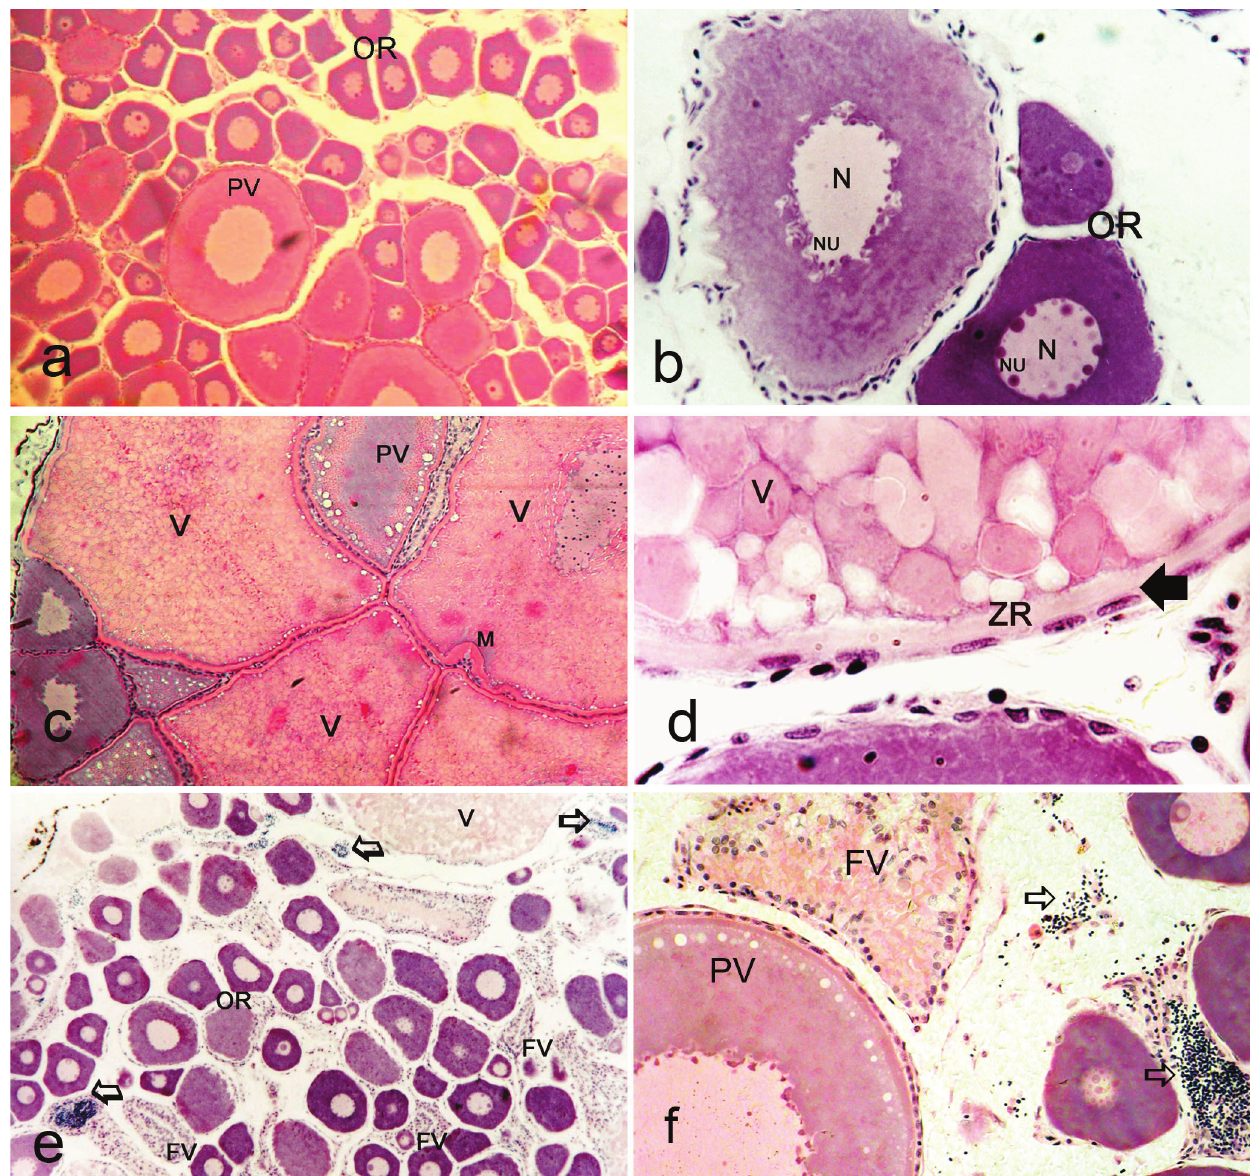
Fig. 1. Histology of ovaries of Compsura heterura at different stages of maturation: maturing ( a , b ), mature ( c , d ) and semi- spent ( e , f ). Black arrow - follicular cells, EZ and white arrow - spermatozoa, FV - post-ovulatory follicles, M - micropile, N - nucleus, NU - nucleolus, OR - early primary growth oocytes, PV - Previtellogenic oocytes, V - vitellogenic oocyte, ZR - radiate zone. Magnification 10x ( a , e ), 20x ( b , c ), 100x ( d , f not significant, for males (r = 0.2531; p = 0.4041) as was well as for females (r = -0.0137; p = 0.9644).